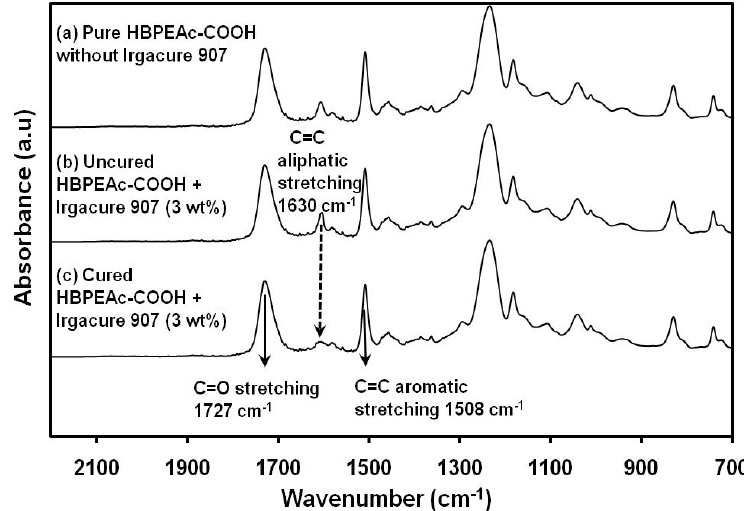
Figure 3. 125.6 MHz 1 H- 13 C CP/MAS solid-state nuclear magnetic resonance (SSNMR) spectra of ( a ) HBPEAc-COOH impregnated Nafion and ( b ) cured neat